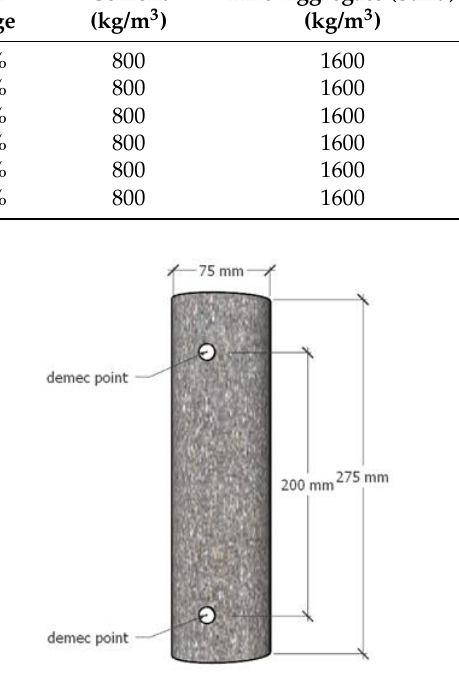
Figure 2. Shrinkage specimen.